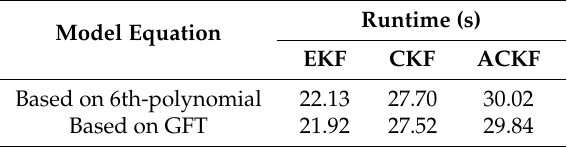
Table 6. The comparison of runtimes for SOC estimation in